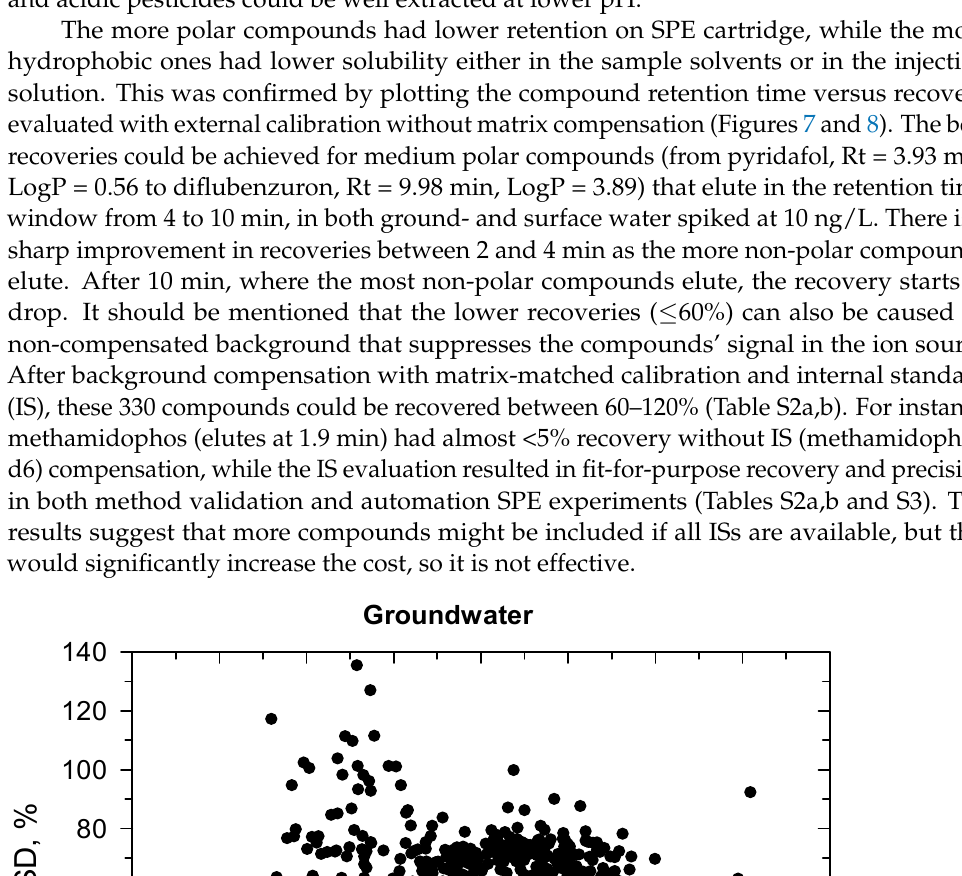
Figure 8. Recovery (%) versus retention time (min) at 10 ng/L in surface water. Results were calcu- lated without matrix compensation.